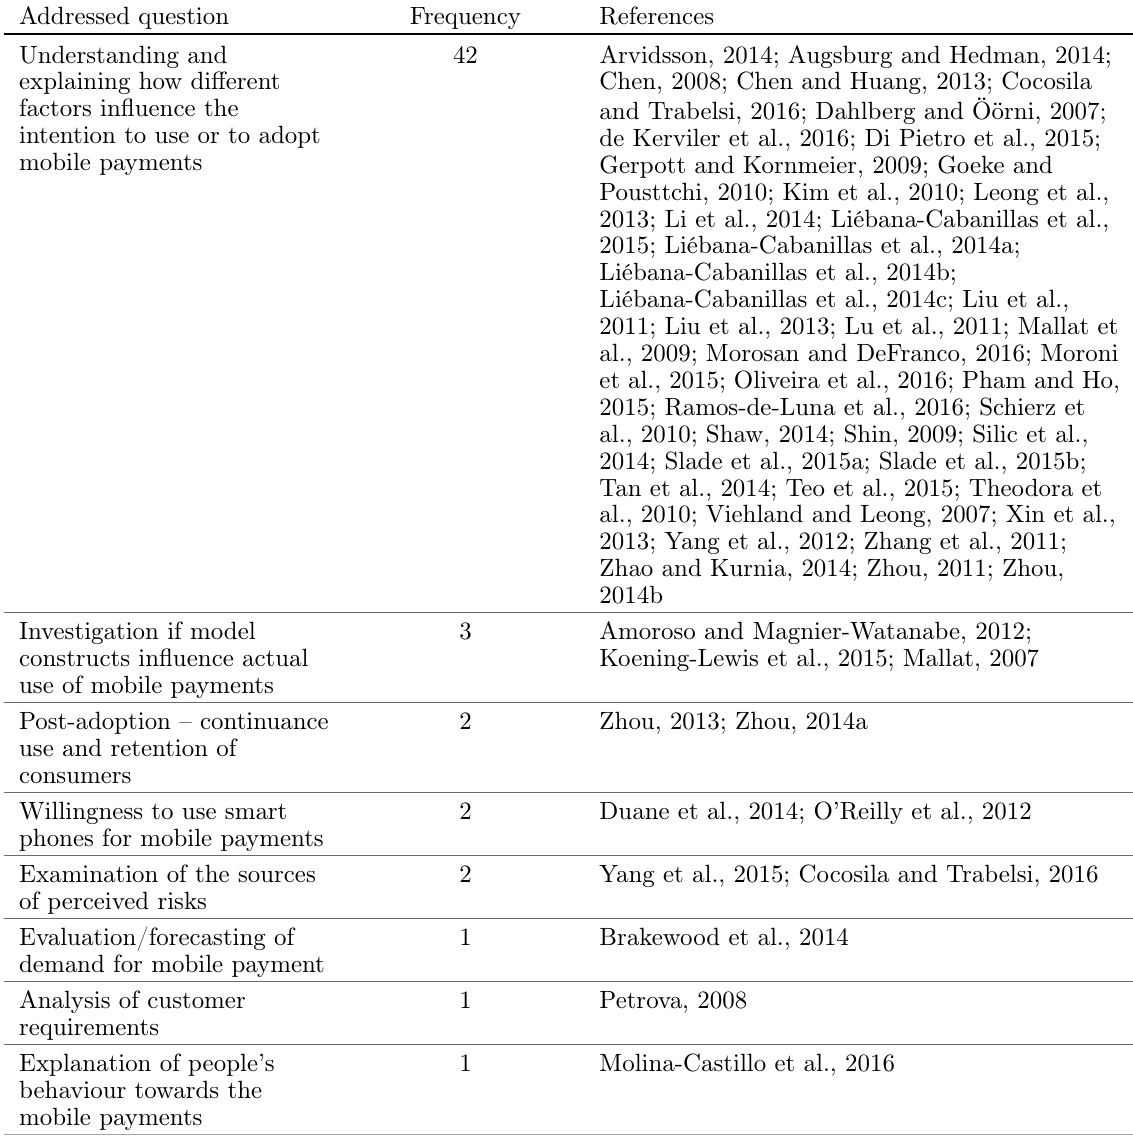
Table C.1 . Classification of papers on customer adoption of mobile payments by